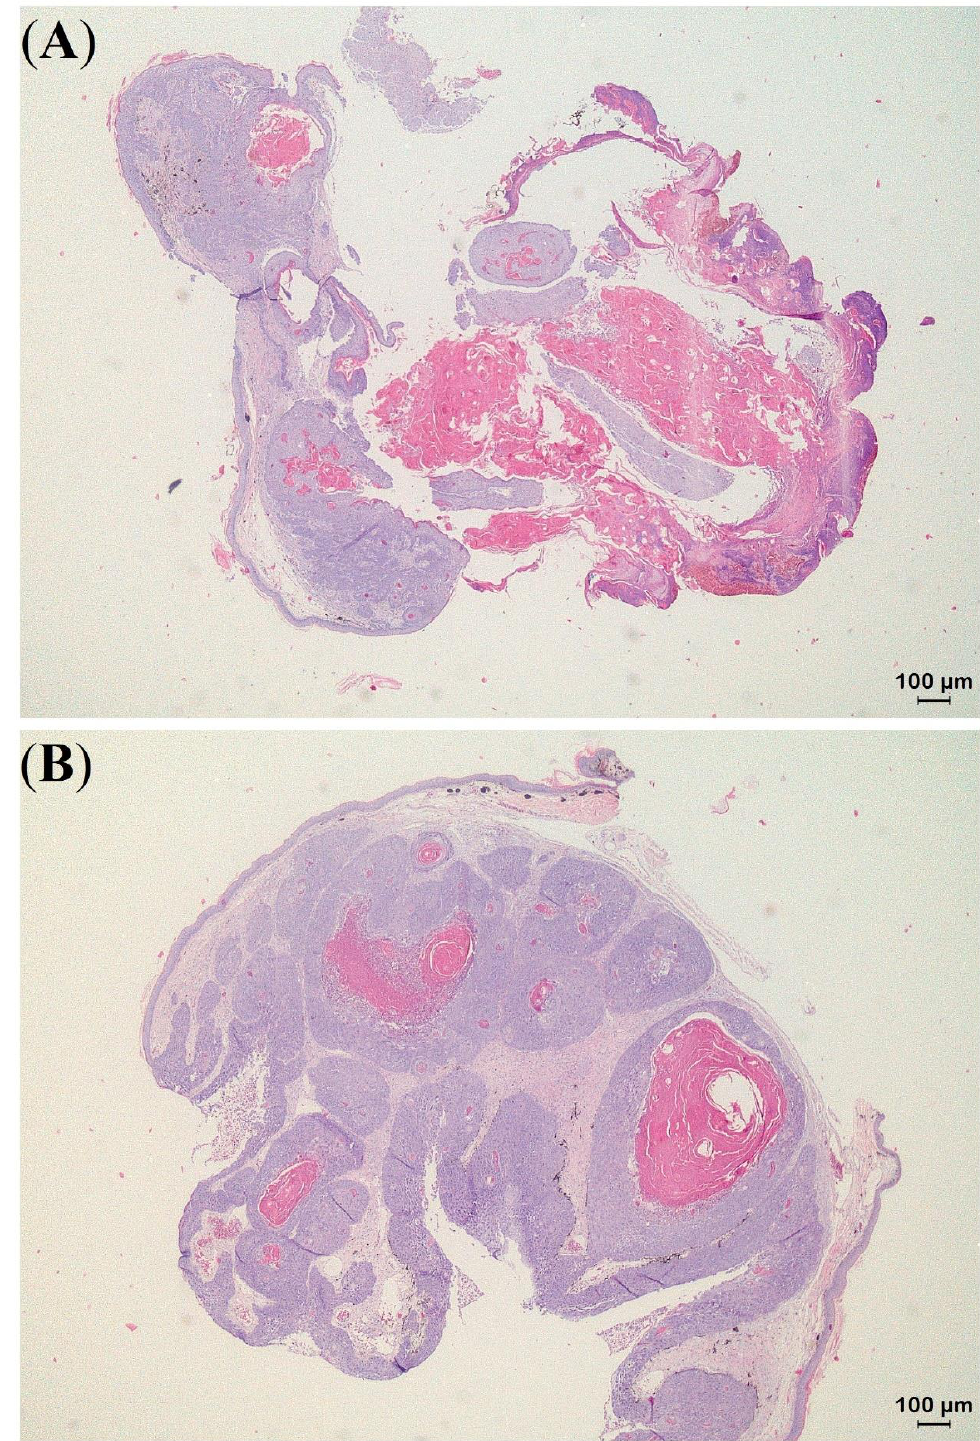
Figure 6. Histologic sections of a keratoacanthoma (KA) with malignant transformation obtained from the eyelid in panther chameleon 1 ( Furcifer pardalis ) with KA features in the central area ( A ) and a well-differentiated SCC at the periphery of the process ( B ).